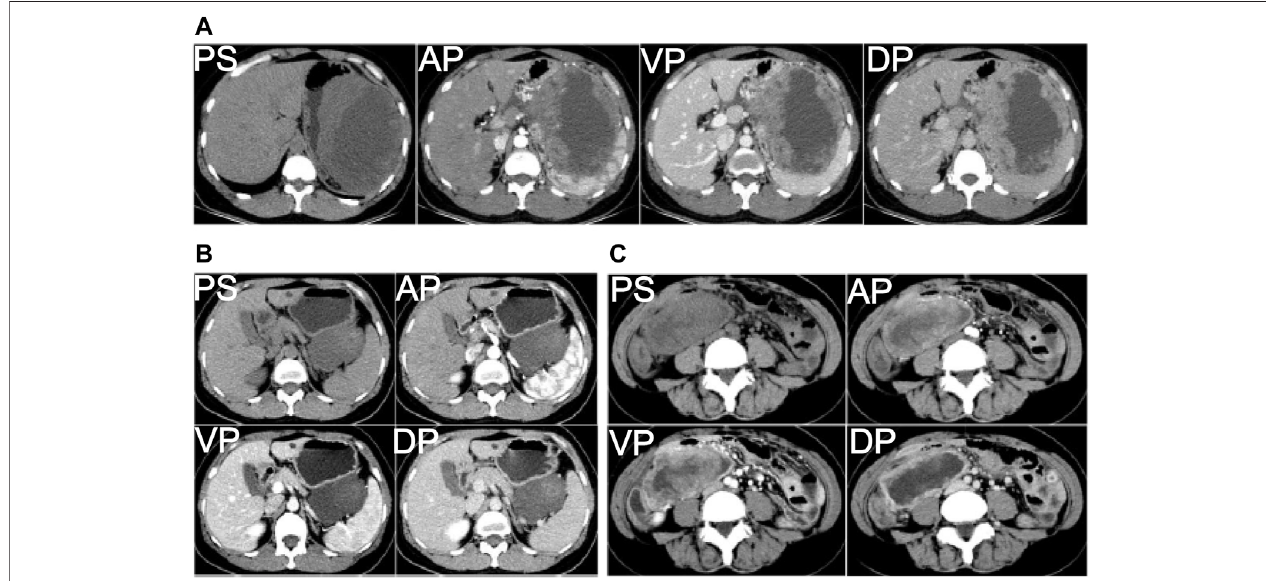
FIGURE1| CTimagingofthefemalepatientatdifferentphasesofthetumor progression. (A) CTimagingofthefemalepatientattheinitialdiagnosisintheXinxiang FirstPeople ’ sHospital(phototakenon2017-08-06). (B) Primarytumorshrinkingafterimatinibtreatmentforaroundfourandahalfmonths(phototakenon2017-12-27). (C) Recurrent tumor was observed seven and a half months after primary tumor resection (photo taken on 2018-08-13). PS: plain scanning, AP: arterial phase, VP: venous phase, DP: delay phase.